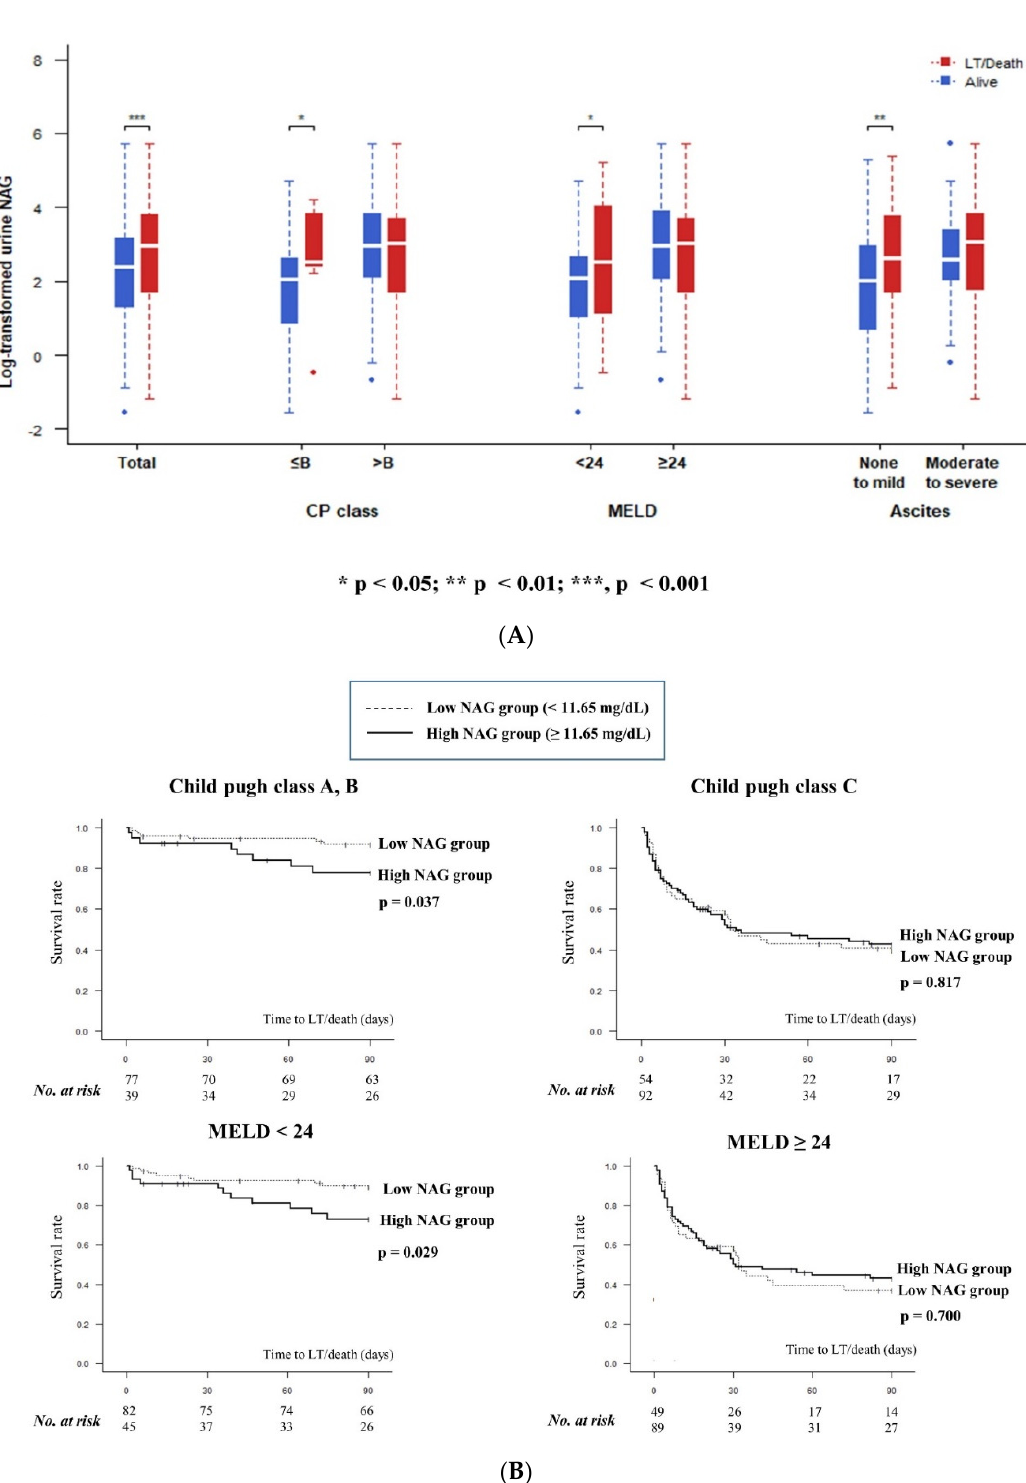
Figure 3. Urine NAG and liver disease severity: ( A ) comparison of urine NAG values; ( B ) transplant-free survival according to urine NAG.